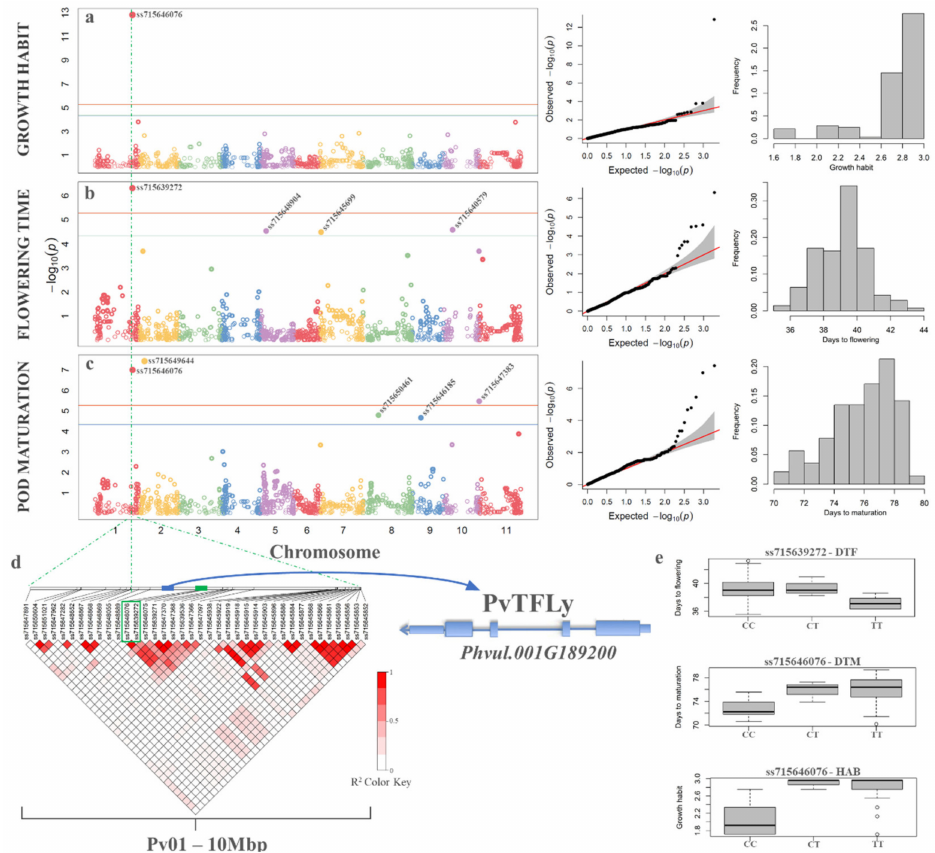
Figure 7. Genome-wide association study of the Carioca association panel. ( a – c ) Manhattan plots showing the association between the SNP markers and the growth habit ( a ), flowering time ( b ) and pod maturation ( c ). The green dotted line passes through the SNPs with the lowest p -values for all of the trait associations on Pv01. ( d ) Linkage disequilibrium (r 2 ) heatmap in the 10 Mb region